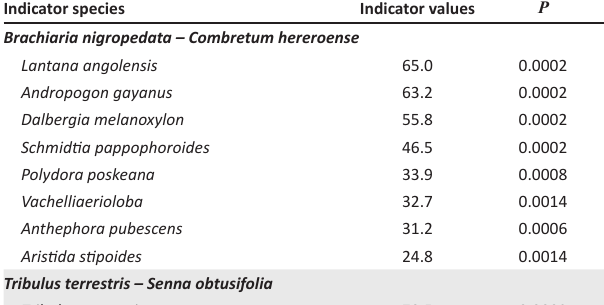
TABLE 2 (Continues...): Indicator species characteristics for 15 class divisions of plant communities in the Savuti-Mababe-Linyanti ecosystem (northern Botswana). Indicator species Indicator